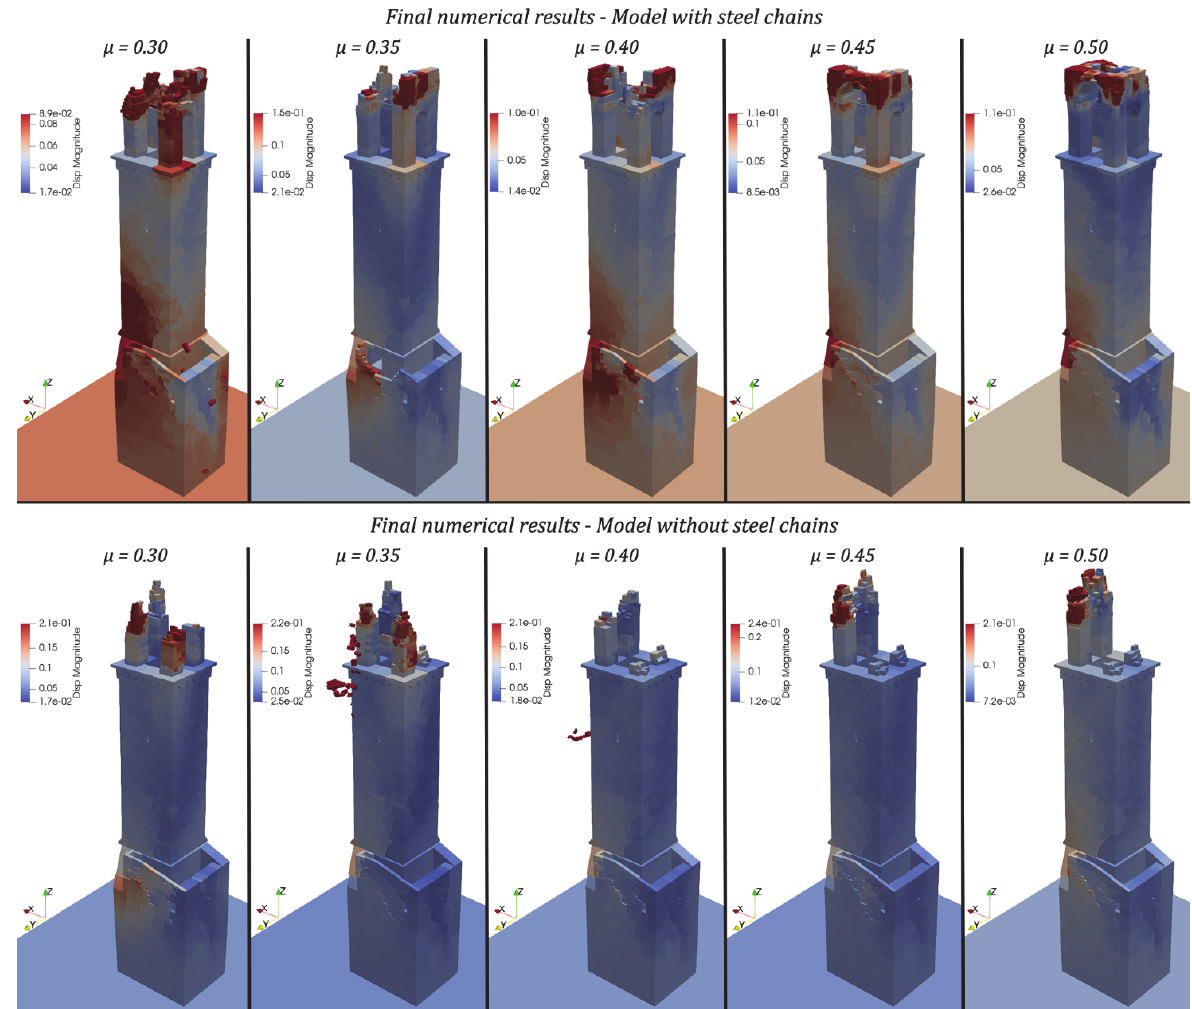
Figure 14: Numerical cumulative damages of the civic tower of Amatrice (Rieti), Italy under the four main shocks recorded in the village during the Central Italy seismic sequence of 2016 for both configurations, with and without the steel chains, at varying of the friction coefficient on the bell